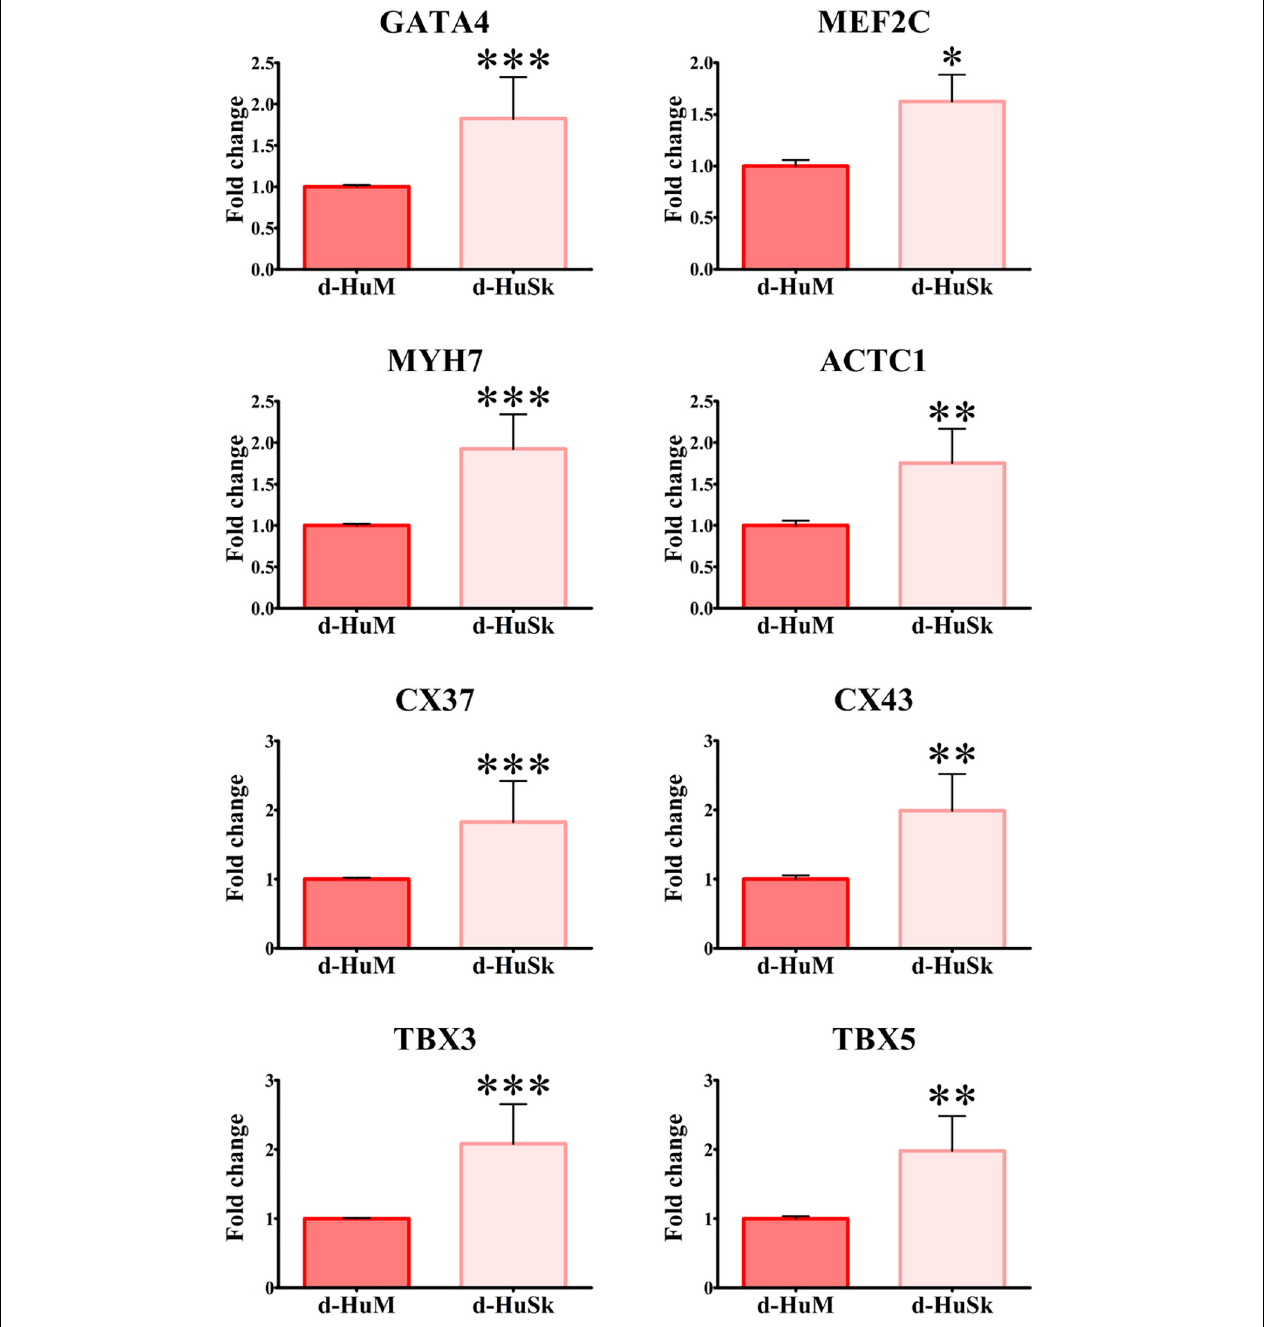
FIGURE 9 | Gene expression analysis of cardiac myocyte markers in hCPCs cultured on d-HuM and d-HuSk for 4 weeks. Real-time PCR analysis of the expression of genes characteristic of cardiac myocytes showing an upregulation of the transcription for all markers in hCPCs cultured on d-HuSk when compared with hCPCs cultured on d-HuM. Asterisks are indicators of the p value obtained in each comparison as follows: significant (* p ≤ 0.05), very significant (** p ≤ 0.01), and extremely significant (*** p ≤ 0.001).